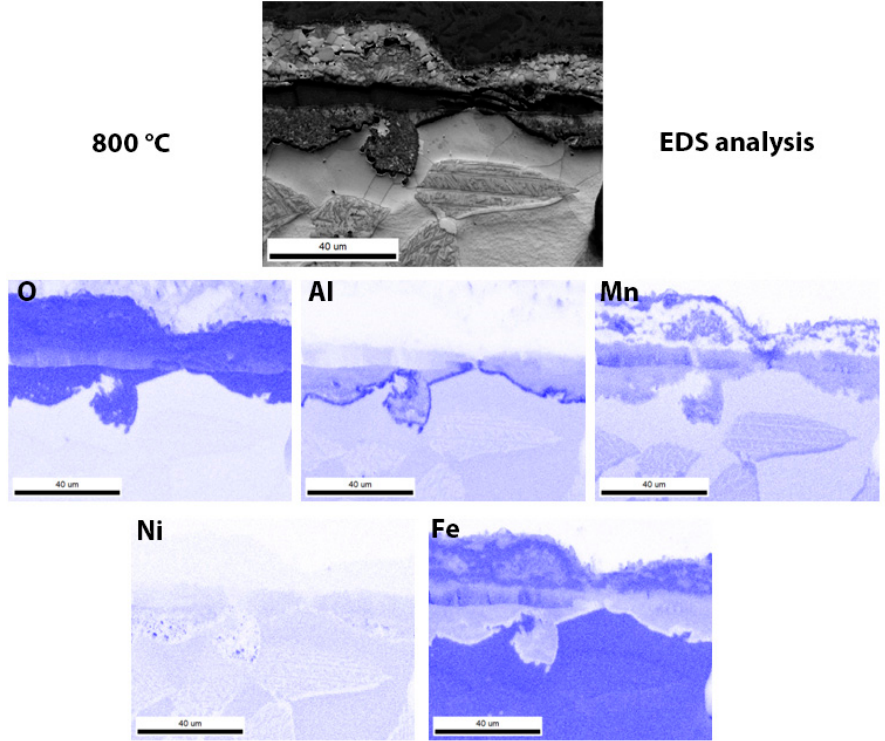
Figure 7. EDS analysis of the surface distribution of the elements in the oxide layer formed after high-temperature oxidation at 800 °C. Oxidation at 900 °C gave similar results (Figure 8), but with more pronounced pref- erential austenite oxidation. The upper oxide layer was lost during sample preparation, but the lower layer was retained. The wüstite and FeAl 2 O 4 hercynite areas are coarser. While hematite and magnetite still make up the bulk, the wüstite is more pronounced and makes up a significant proportion of the oxides. The IPF-Z results correspond to the mid- dle oxide layer formed at 800 °C, as they are difficult to index. The oxidation front is rich in Al and depleted in Ni and Mn (Figure 9), while the oxides are enriched in Mn. Further- more, areas of Ni enrichment appear in the oxides directly above the Al-enriched areas.